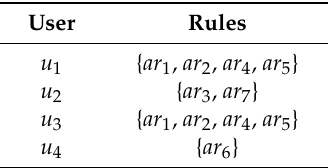
Table 12. Sets of di ff erent user_rules γ ( u ).